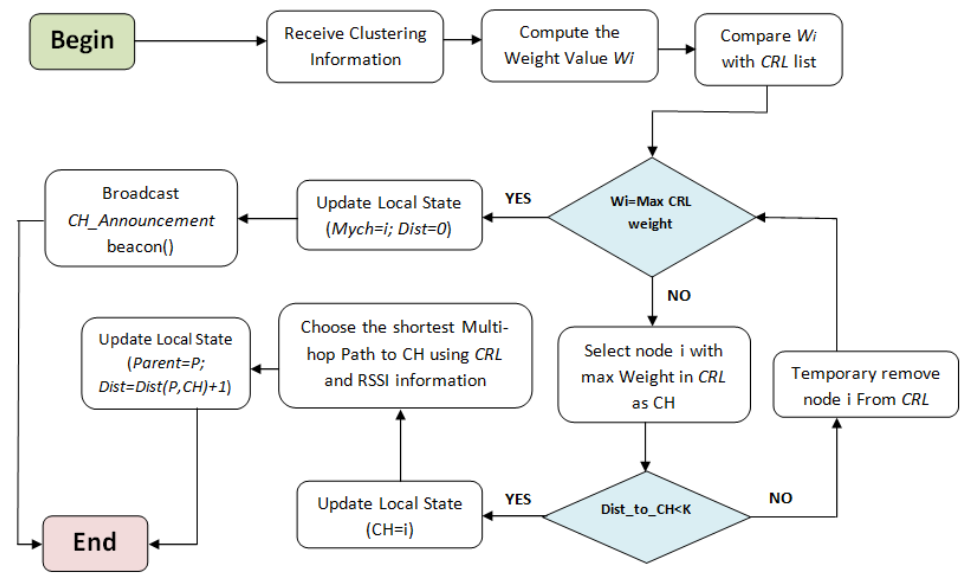
Figure 5. The cluster head election